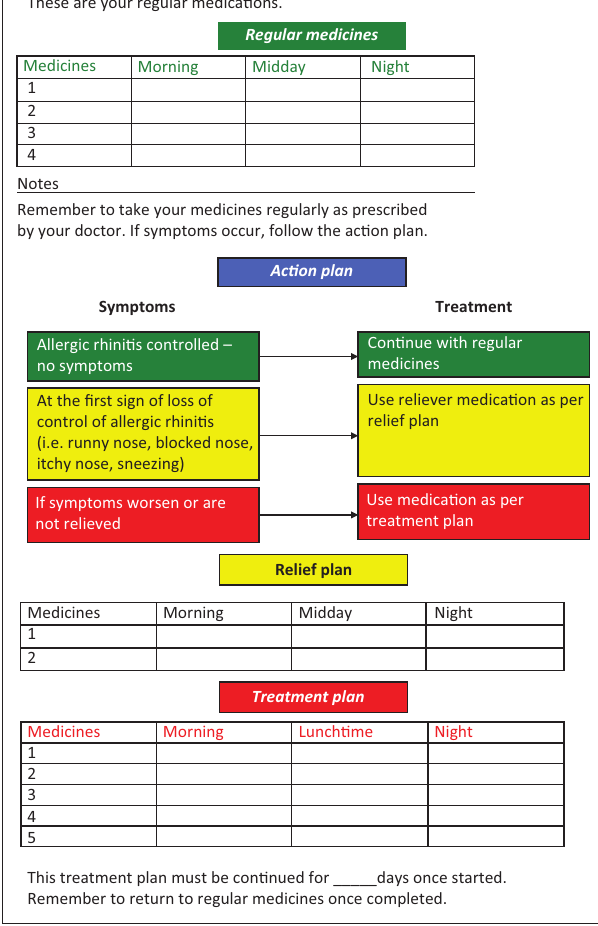
FIGURE 3: Patient directed management card for allergic